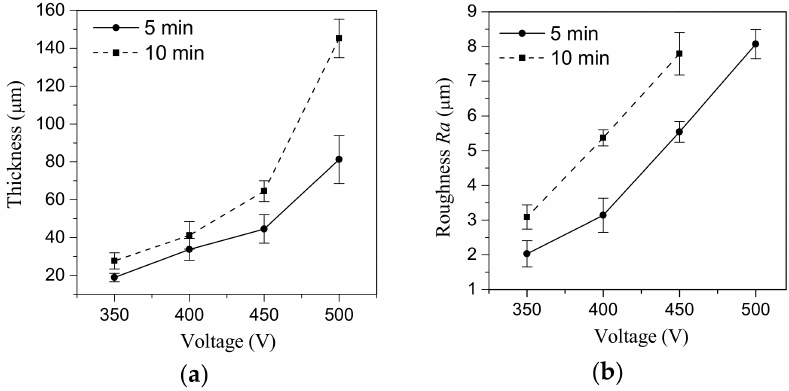
Figure 3. The thickness ( a ) and roughness Ra ( b ) of the CaP coatings against the MAO voltage.